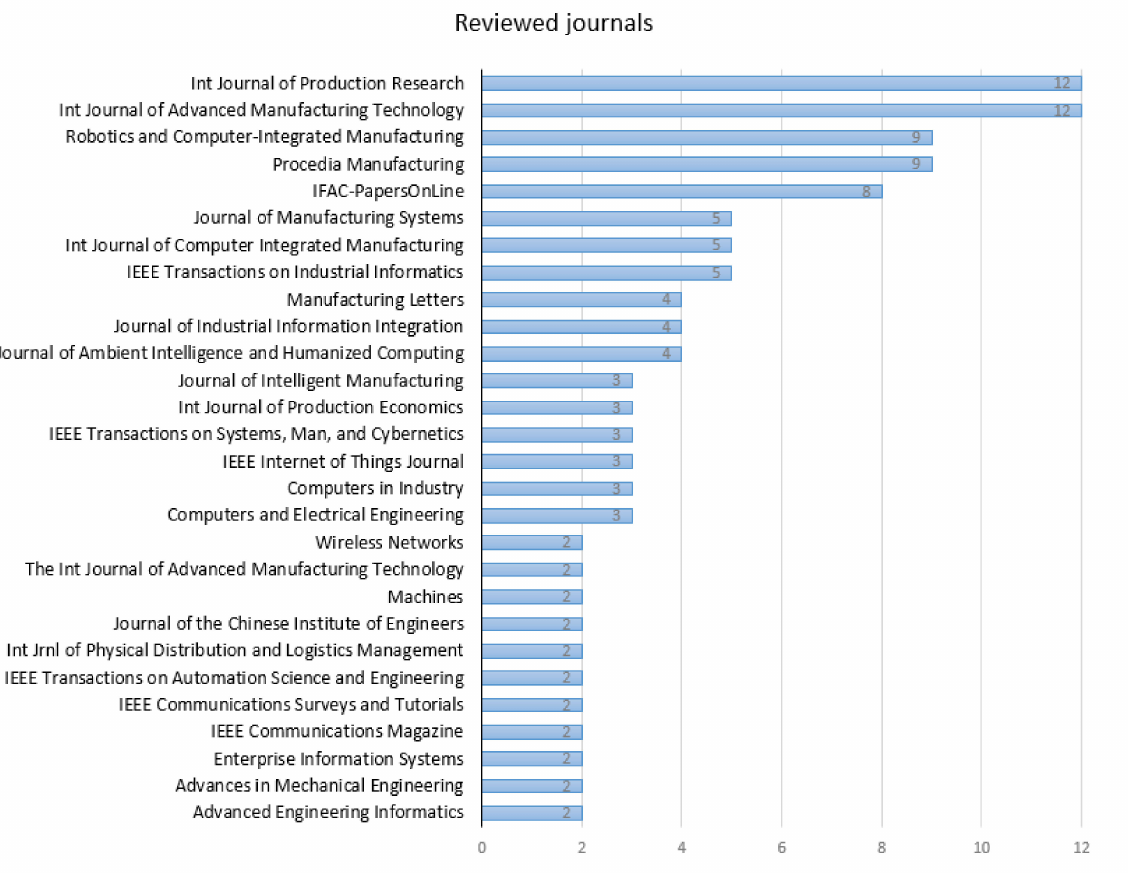
Figure 3. Reviewed journals with more than one